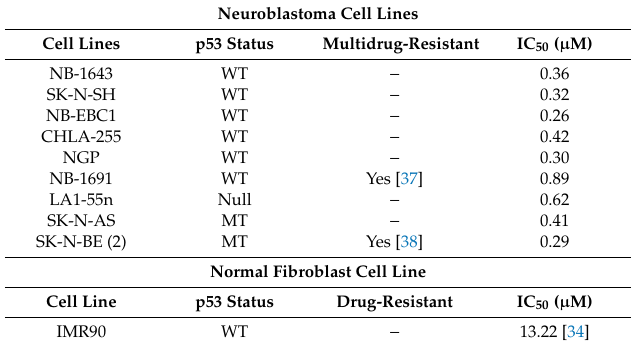
Table 1. IC 50 of SP141 in neuroblastoma cell lines of varying p53